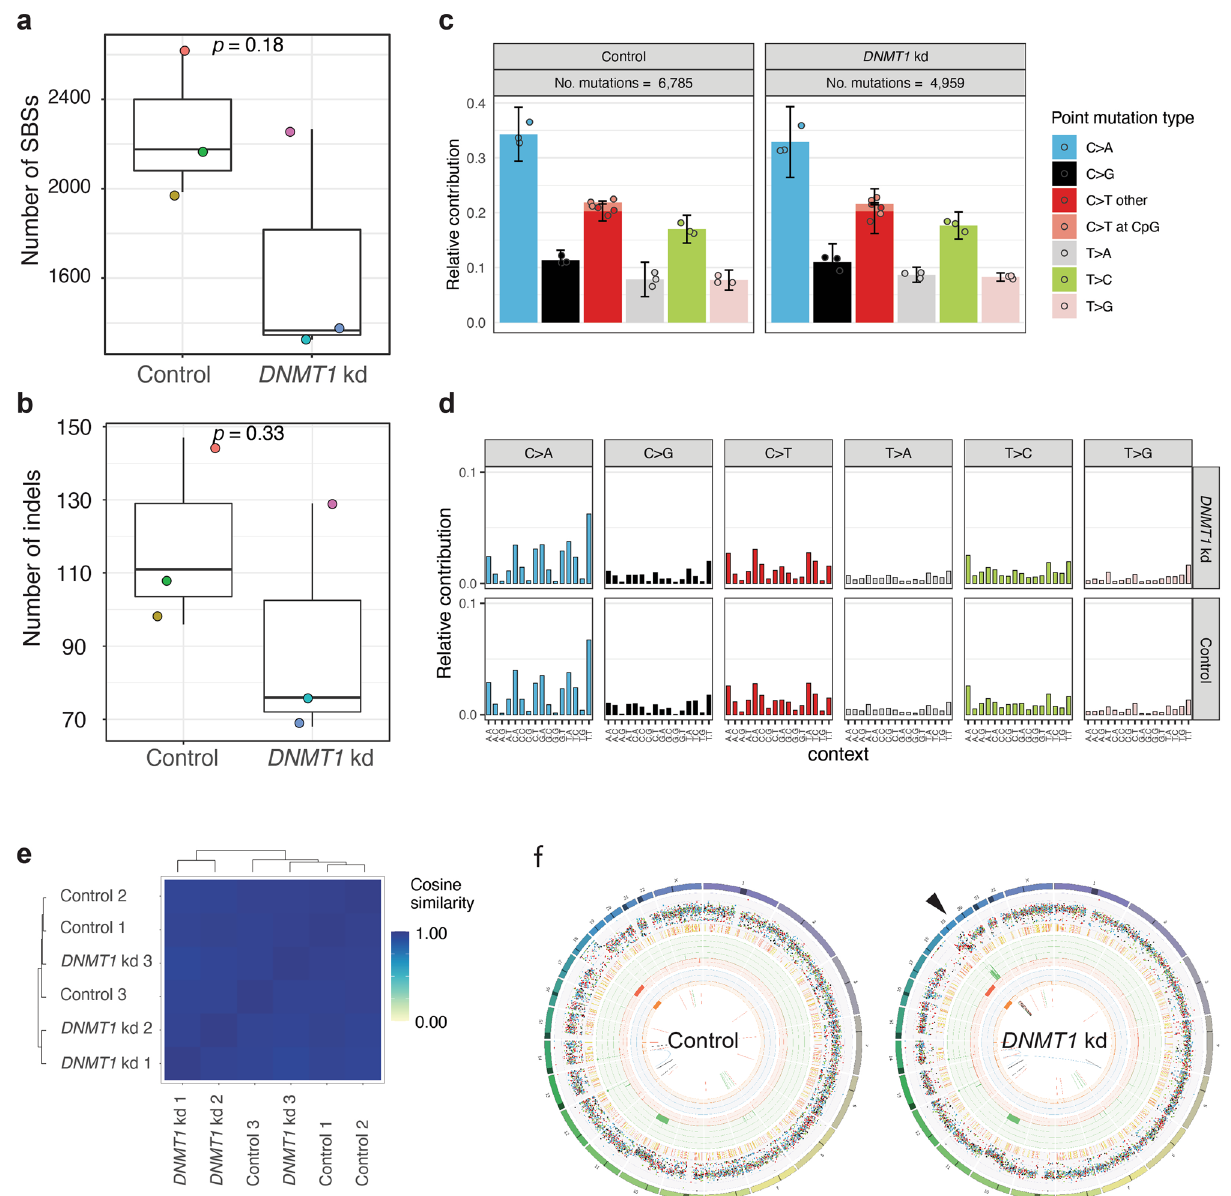
Figure 3. Mutational impact of global DNA methylation loss ( a ) Box-plot with the individual data points of the number of single base substitutions per clone. Each clone is represented by a unique color. ( b ) Box-plot with the individual data points of the number of indels per clone. Each clone is represented by a unique color. Same color scheme as in a. ( c ) Average mutational spectra of (left) control clones and (right) hypomethylated DNMT1 knockdown clones. ( d ) Average mutational profiles of (top) hypomethylated DNMT1 knockdown clones and (bottom) control clones. ( e ) Cosine similarity between the mutational profiles of hypomethylated DNMT1 knockdown clones and control cells. ( f ) Circos plots from a clone with (left) normal DNA methylation levels and (right) a hypomethylated DNMT1 knockdown clone. Arrowhead denotes a chromothripsis event at the q-arm of chromosome 19, which was observed in 2 out of 3